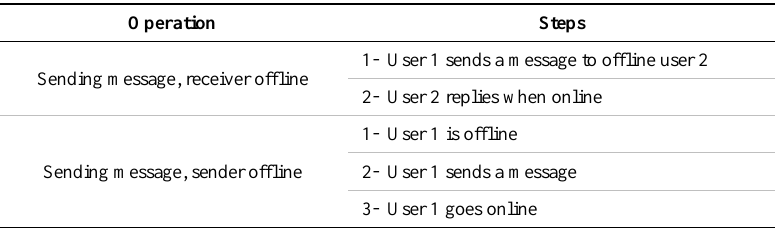
Table 3. Message state experiments